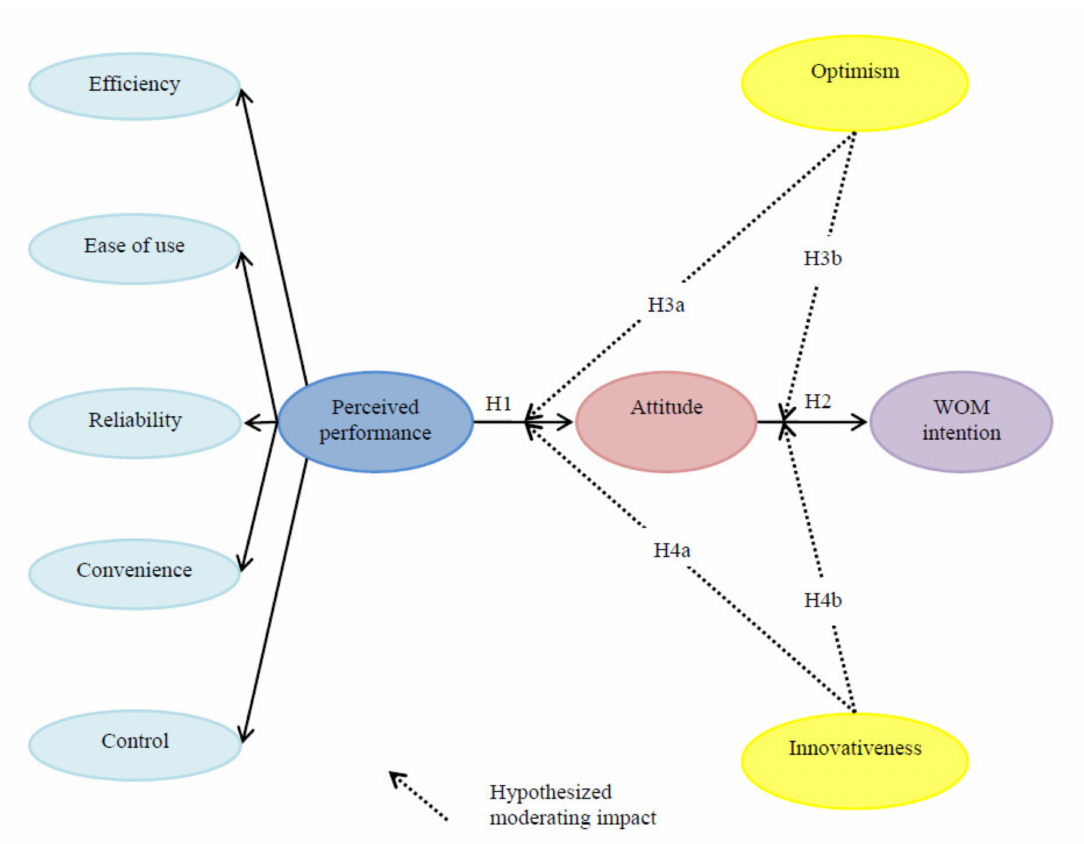
Figure 1. Proposed conceptual model. Note: H =